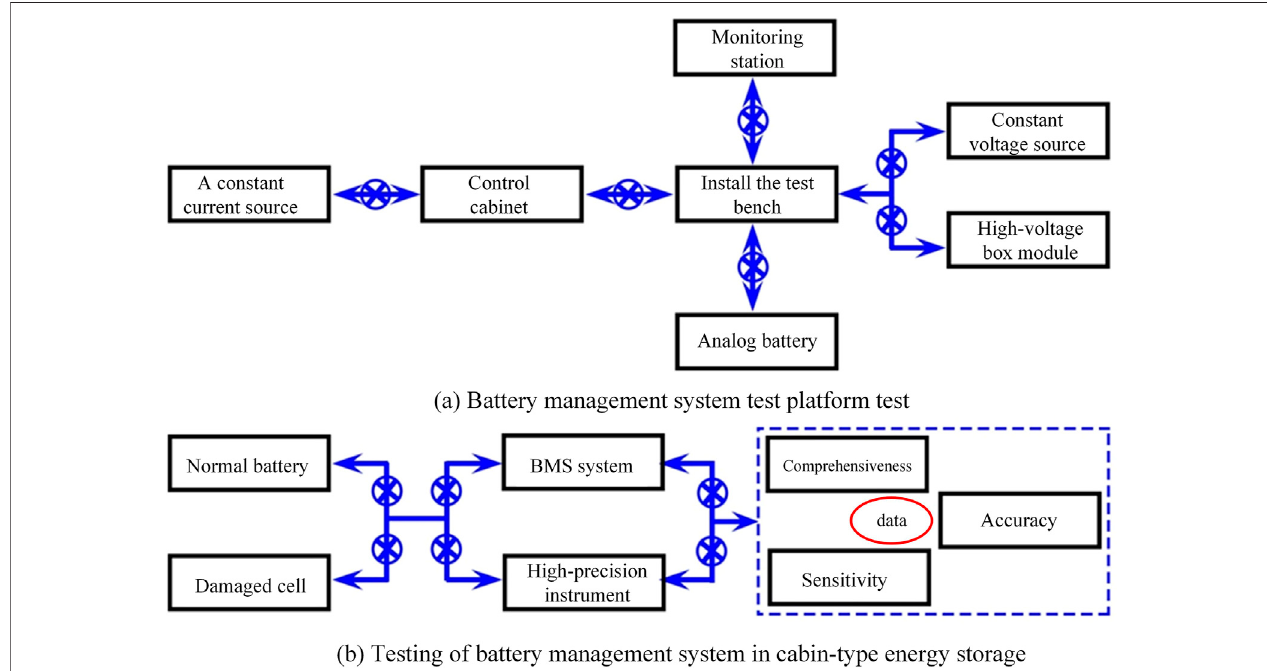
FIGURE 12 | Inspection test scheme of battery management system (BMS).